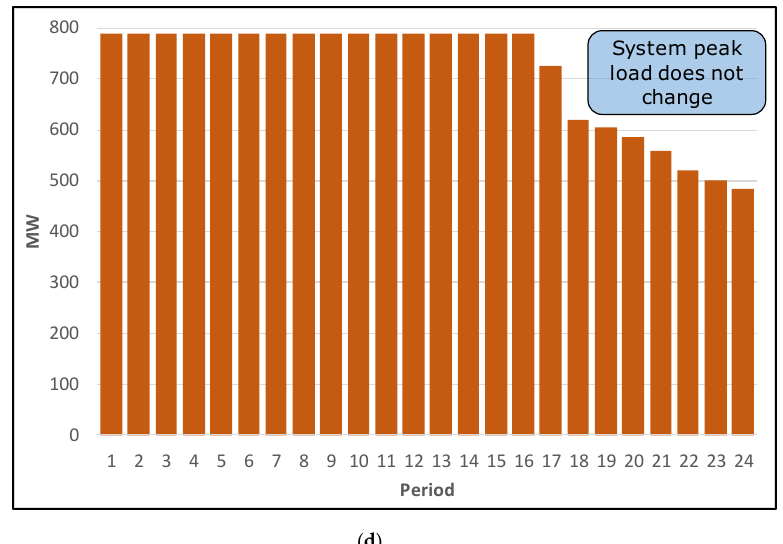
Figure 6. Alterations in resulting system LDC for scenario C: ( a ) daily LDC, ( b ) peak imports, ( c ) off-peak exports, ( d ) new LDC.